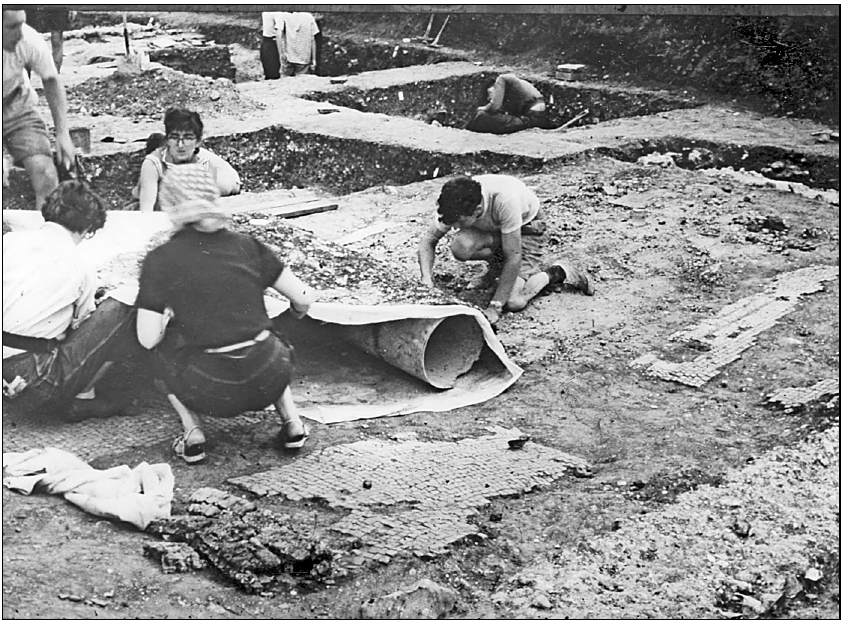
Figure 7 Lifting a mosaic in insula XXVII, building 3, Verulamium,